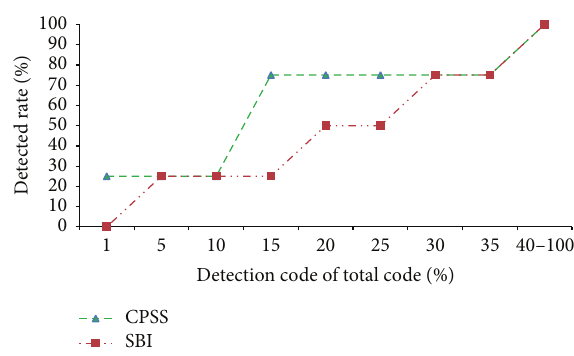
Figure6:Comparisonoflocationeffectofconditionjudgmentfault.